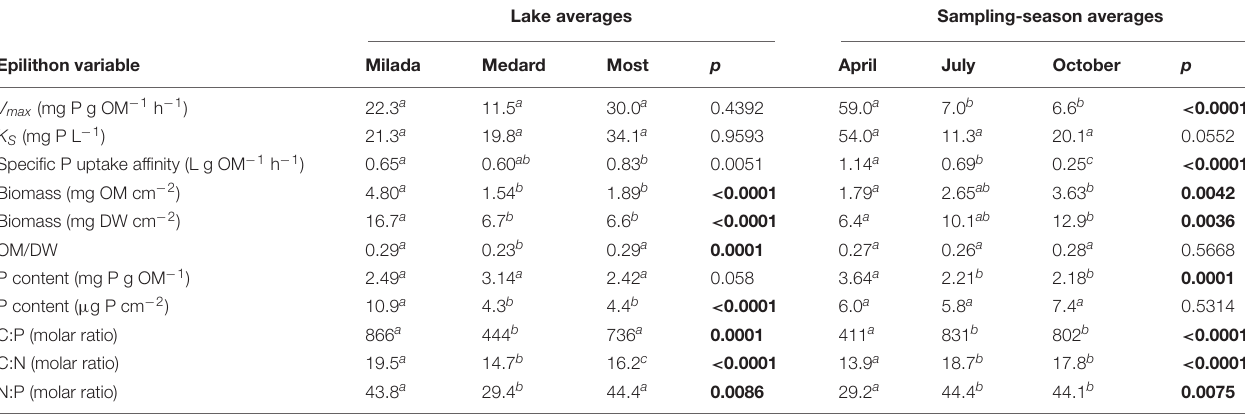
TABLE 2 | Average values of epilithon biomass- and P uptake-related variables measured in three post-mining lakes in the Czech Republic in 2019. Lake averages